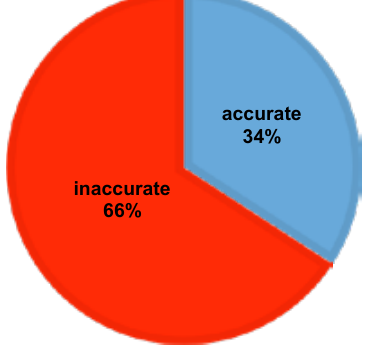
Fig. 4. Amateur Group Free Throw PercentageF ig. 3. Expert Group Free Throw Percentage